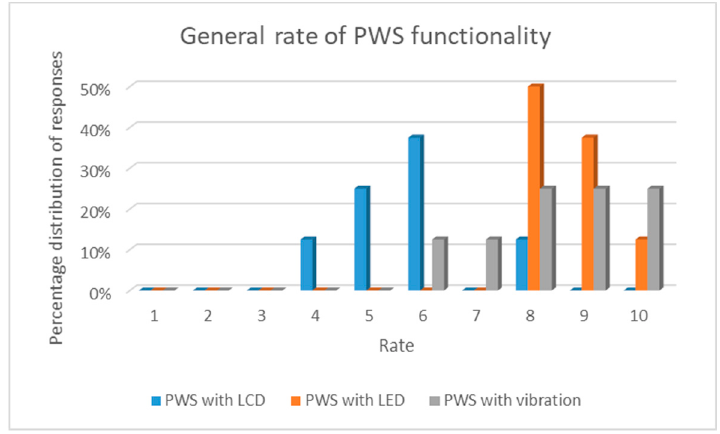
Figure 4. Survey results of the overall PWS functionality assessment, where 1—the lowest rating, 10—the highest rating.